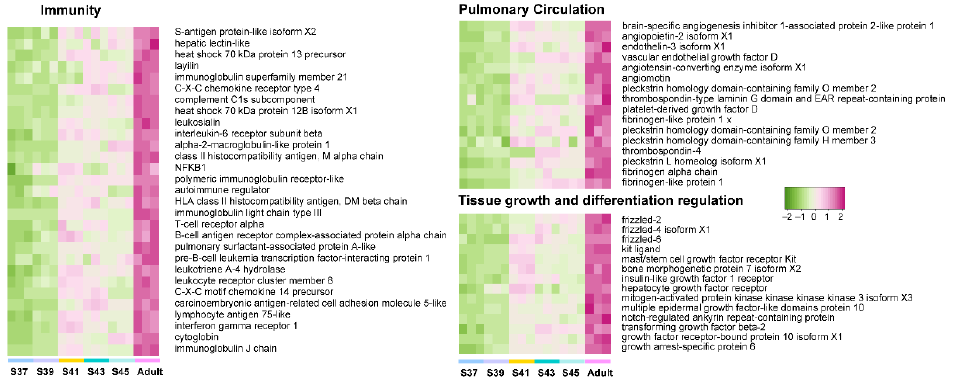
Figure 6. The variation patterns of featured genes involved in immunity, pulmonary circulation, and tissue growth and differentiation regulation in the adult phase ( n = 3 each stage).